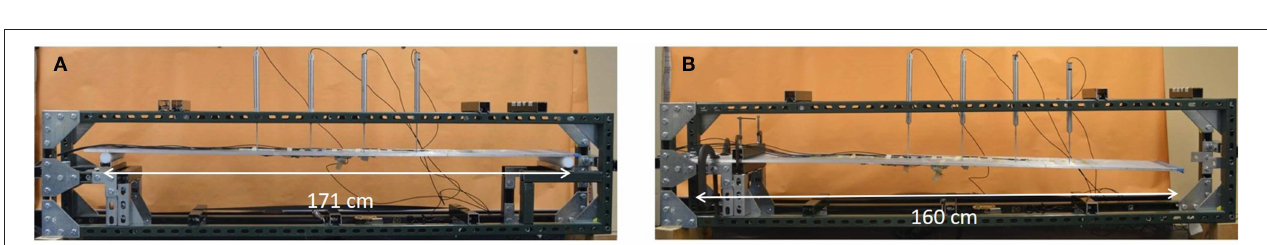
FIGURE 5 | (A) RMS error and (B) Pearson coefficient for the estimated displacement compared to actual displacement for a FEA transient analysis of a simply supported beam and (C) RMS error and (D) Pearson coefficient for the estimated displacement compared to actual displacement for a FEA transient analysis of a cantilever beam.